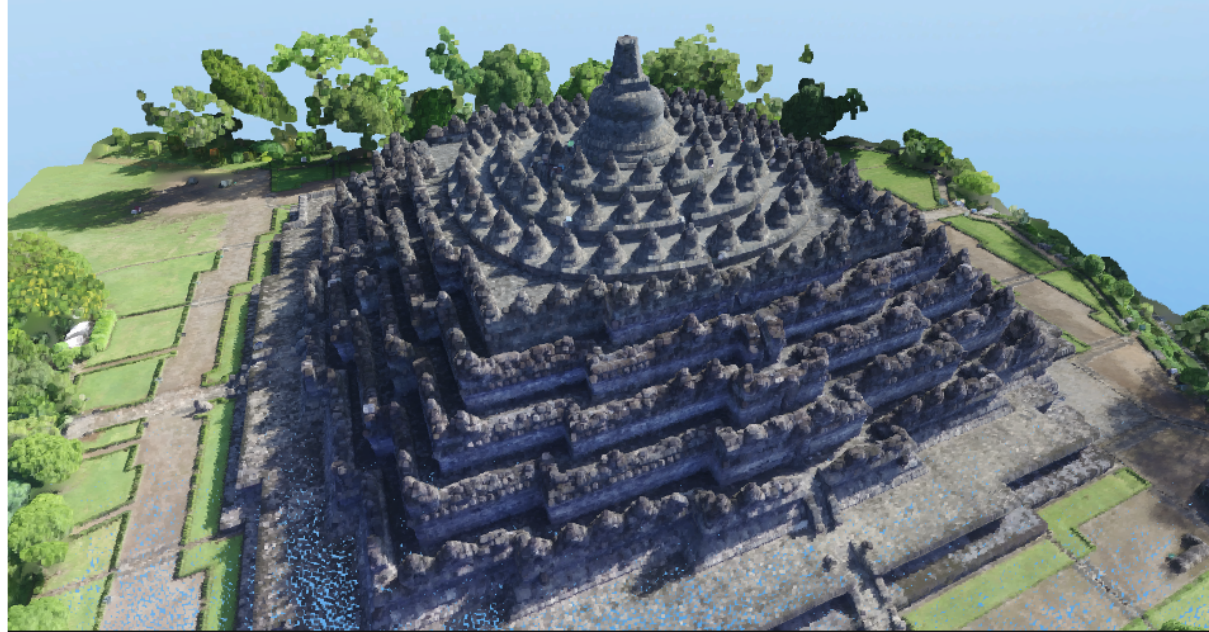
Figure 9. Bird’s eye view of the Borobudur Temple viewed in our VR system.